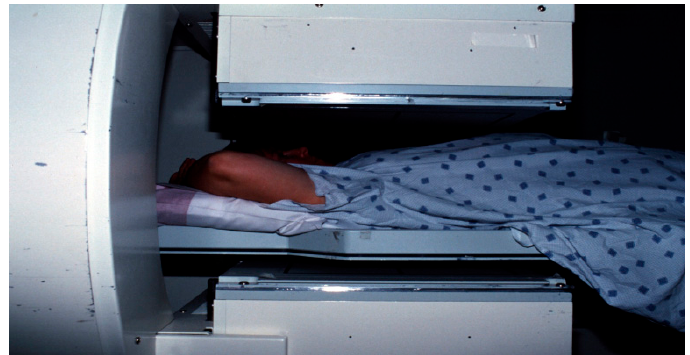
Figure 13. Anterior planar images following radiopharmaceutical injection.